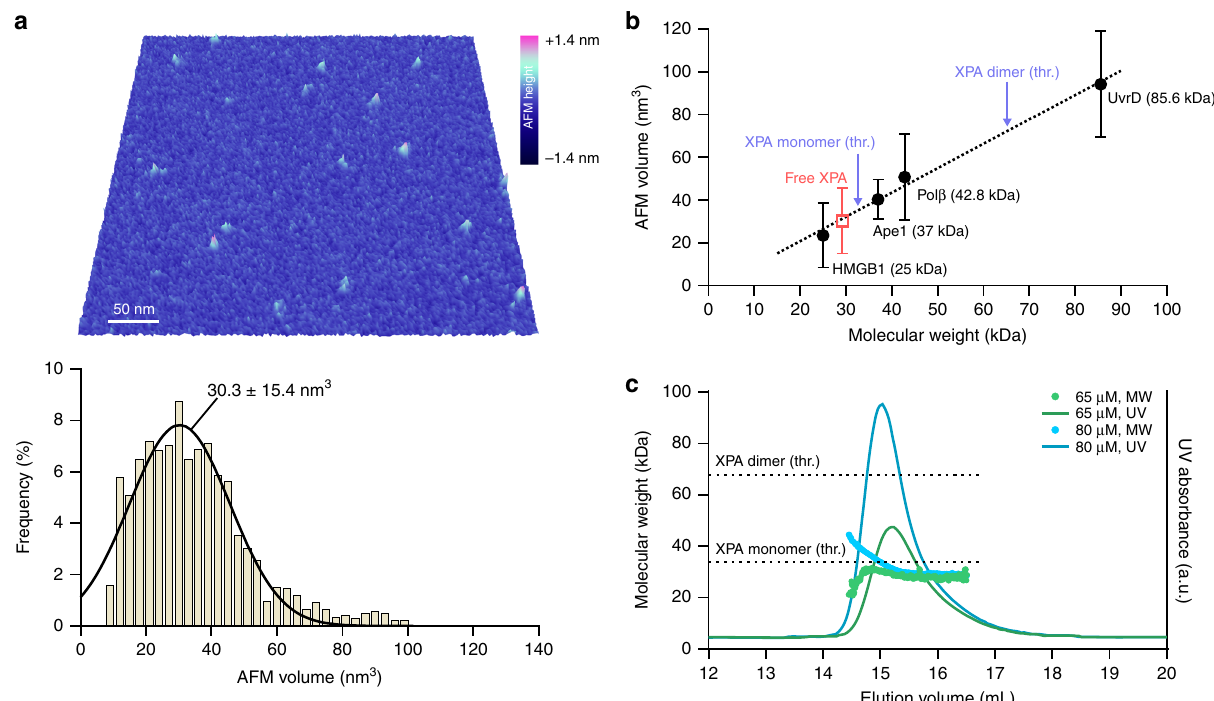
Fig. 2 XPA is a monomer in the absence of DNA. a Top, representative 3D AFM image of free XPA. Bottom, histogram and Gaussian fi t of free XPA molecules imaged by AFM ( n = 1451 particles). Gaussian is labeled with mean and s.d. b Standard for calculating molecular weight from AFM volumes. Volumes of free proteins imaged by PeakForce Tapping AFM were calculated and respective histograms were fi t by Gaussian distributions. Solid black circles, proteins used to generate the standard plotted against their known MW (results and n values for each in Supplementary Fig. 3). Dashed line, linear regression, resulting in the calibration curve: Volume (nm 3 ) = 1.14 × MW (kDa) – 2.00. R 2 = 0.990. Purple arrows point to theoretical (thr.) volumes for the puri fi ed His- fl XPA monomer (32.6 kDa) and dimer (65.2 kDa). Open red square, experimental His- fl XPA AFM volume (see a), corresponding to a molecular weight of 28.4 ± 15.3 kDa. Errors bars indicate s.d. of the Gaussian distribution. c Molecular weight (MW) determination by SEC-MALS of XPA at 65 μ M (green) and 80 μ M (blue). Theoretical molecular weights for the puri fi ed His- fl XPA-StrepII monomer (33.9 kDa) and dimer (67.8 kDa) are indicated by dashed